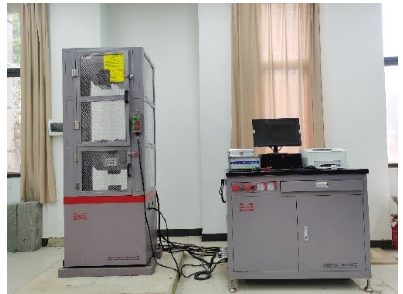
Figure 6. HUT305A type 300 kN microcomputer-controlled electrohydraulic servo universal test- ing